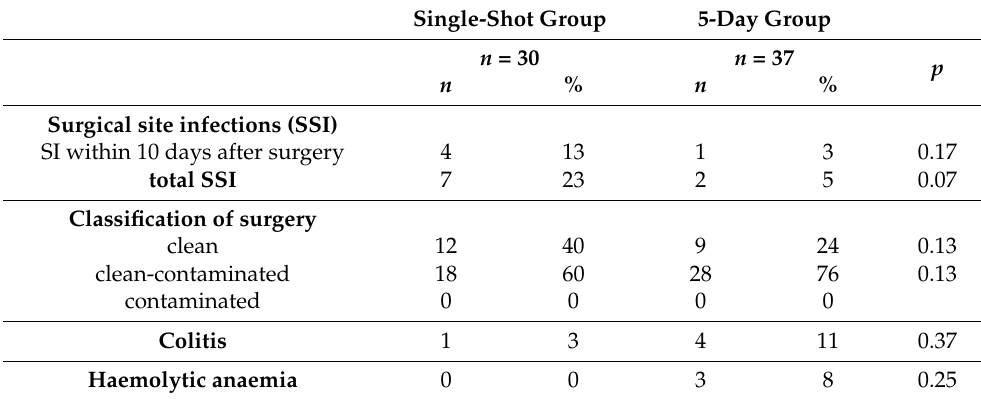
Table 2. Comprehensive overview of study groups and study